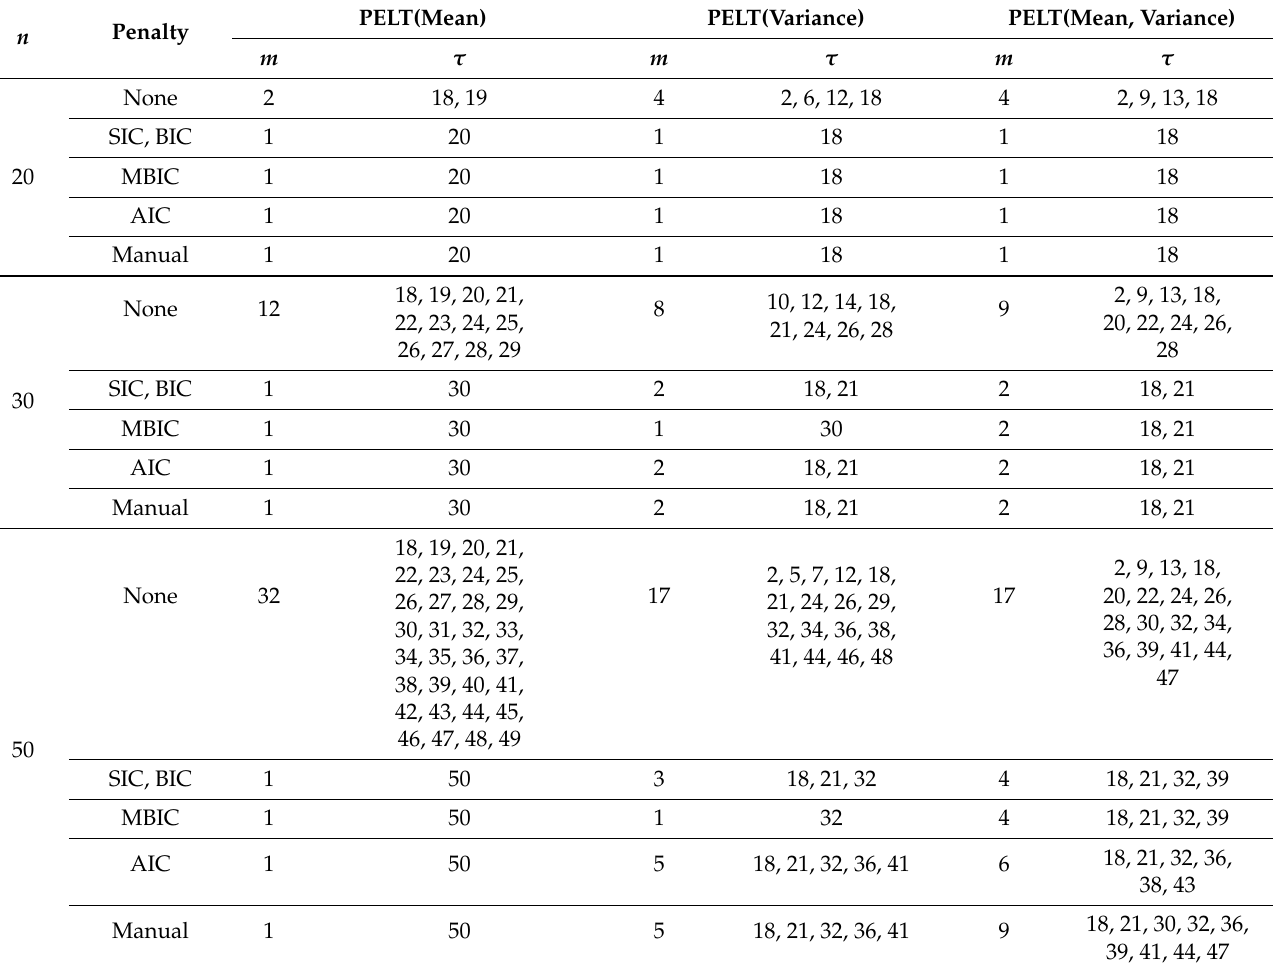
Table A9. PELT Algorithm Result for Poland’s COVID-19 Transmissibility